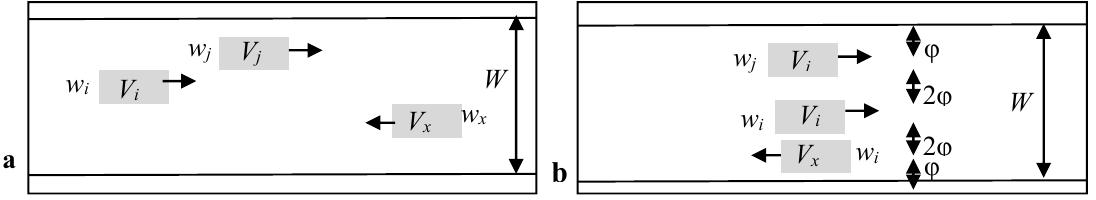
Figure 4. Notations for deciding feasibility of overtaking when three vehicles can be accommodated within the road width: ( a ) Initial Positions; ( b ) Final Positions.